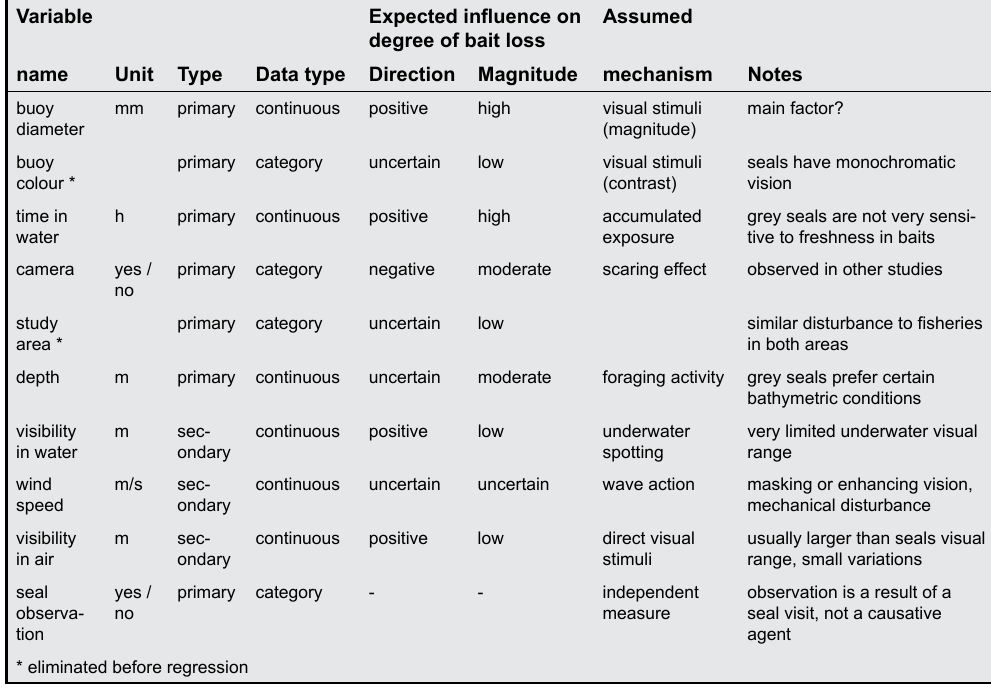
Table 2. Data on primary and secondary variables collected in the field experiment with baited